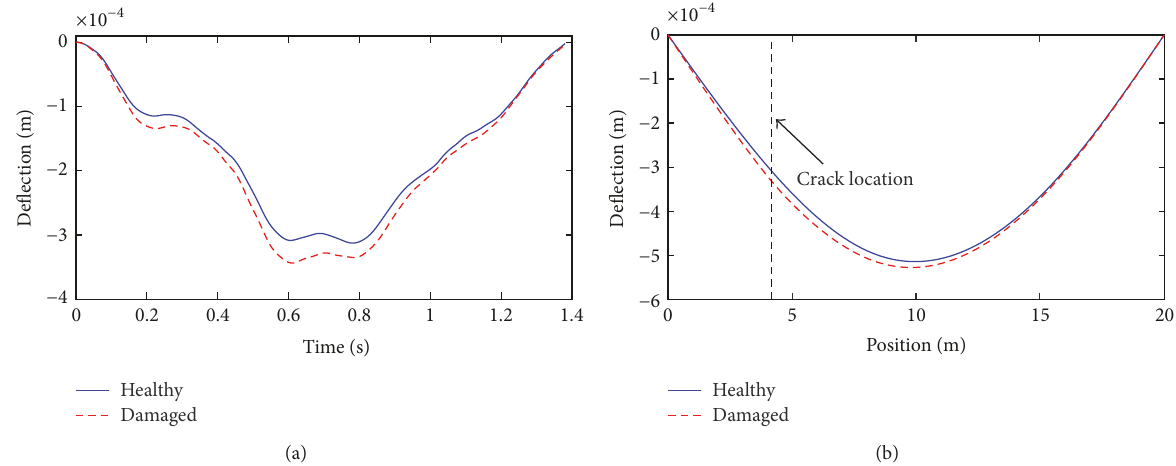
Figure 4: Cross sections through the contour plot of deflections in Figure 2(a): (a) line A, constant “sensor” position at 4.2 m; (b) line B, constant time at 0.8 s.